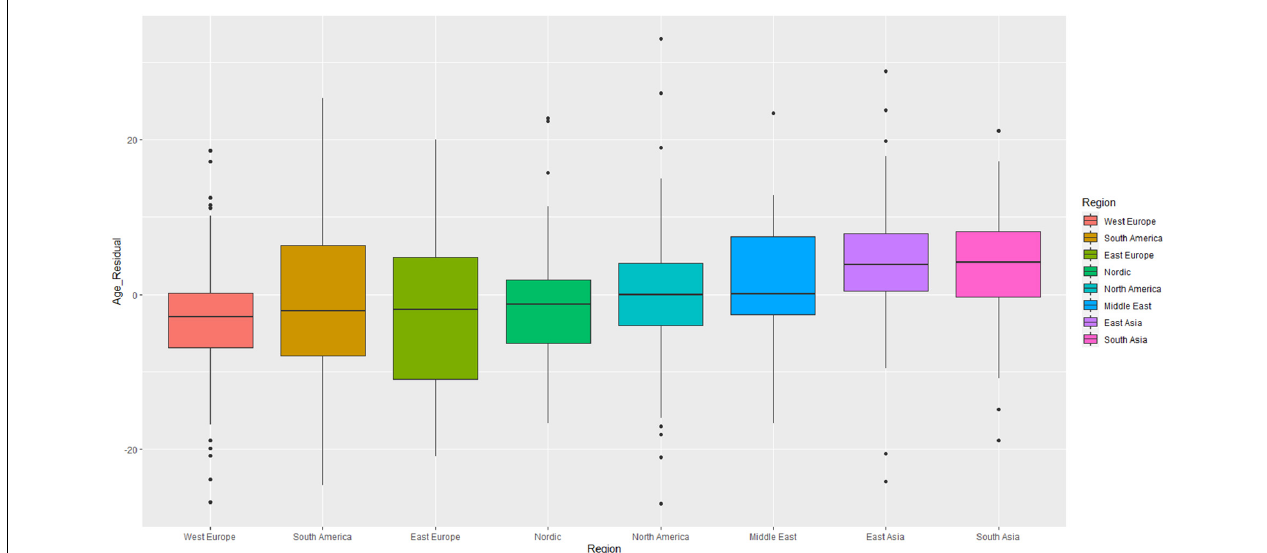
FIGURE 1 | Business leader ages by geographical region. Age depicted in the figure is adjusted for the presence of the economic and elderly population covariates. See SOM for figures presenting raw (i.e., unadjusted by covariate) age scores.